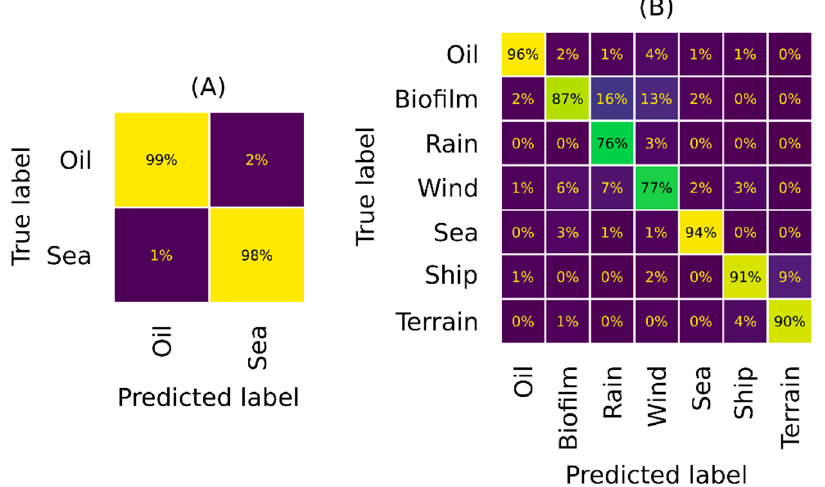
Figure 7. Confusion matrices for the oil detector ( A ) and the ocean feature classifier ( B ) random forest models.